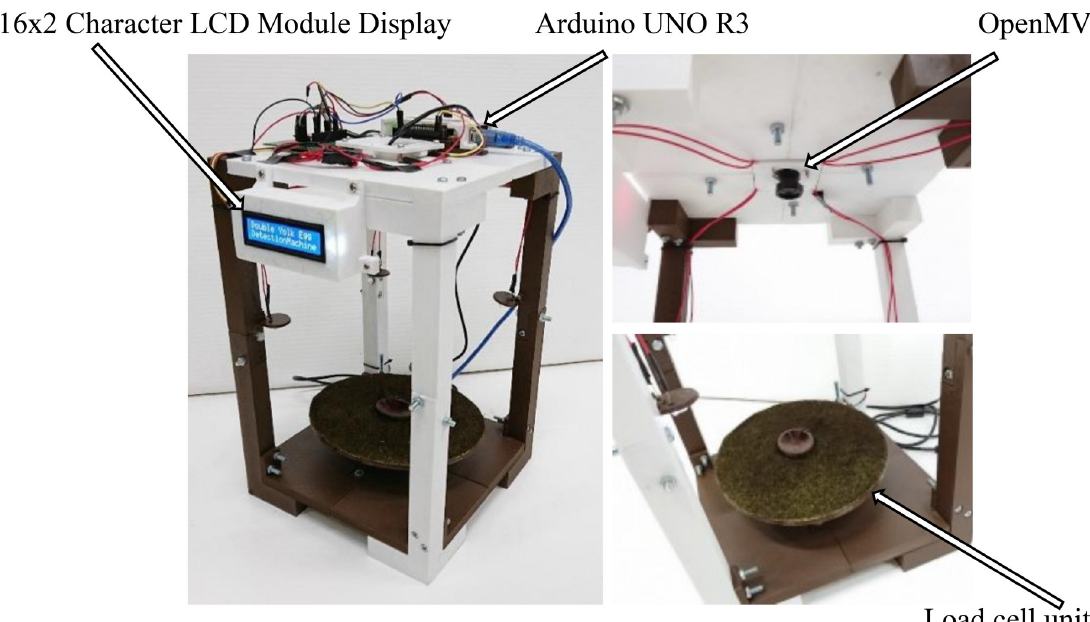
Fig 14. A prototype of double yolk egg